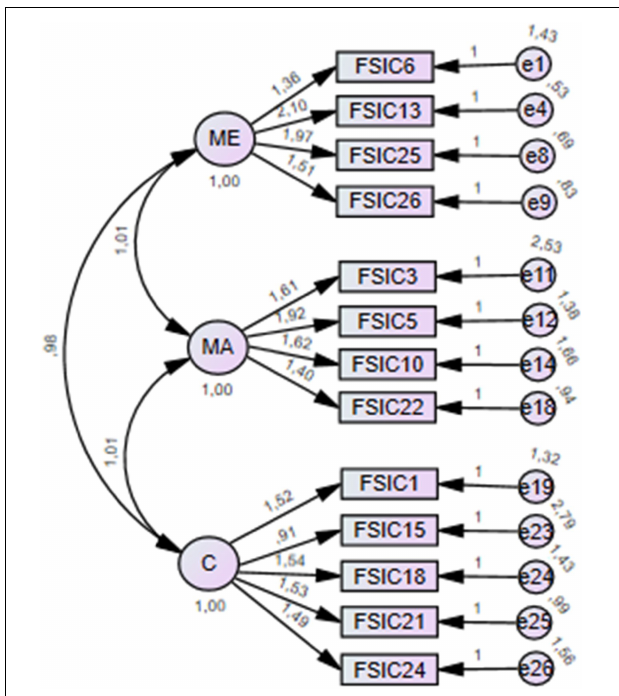
FIGURE 1 | Final model for confirmatory factor analysis.